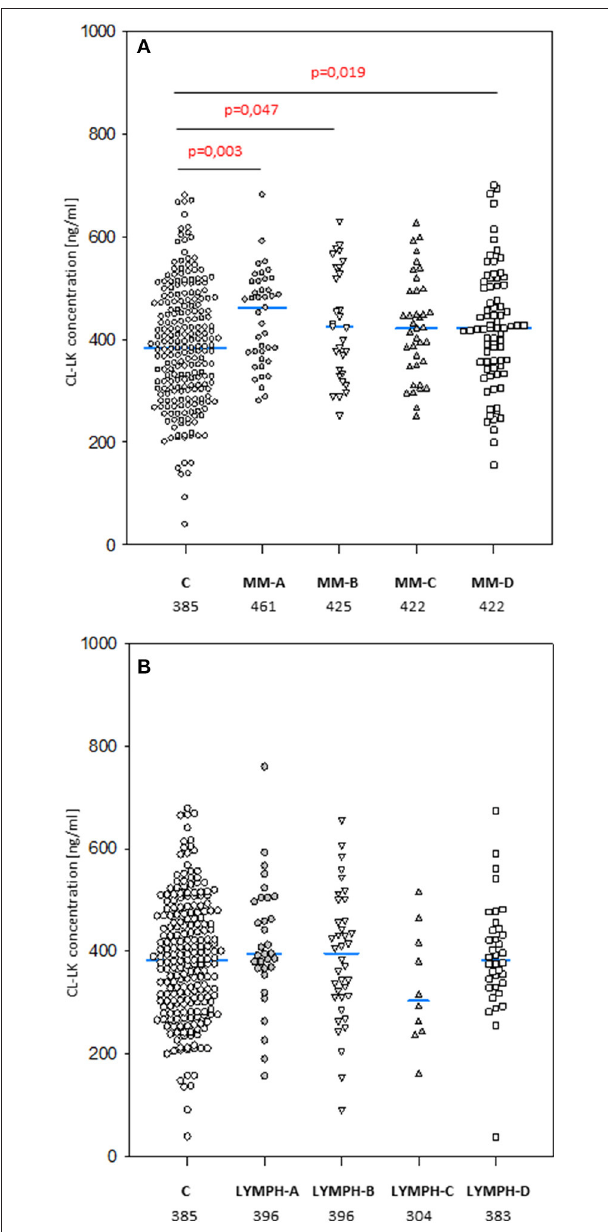
FIGURE 5 | Collectin CL-LK serum concentrations in patients (before conditioning chemotherapy) and controls. Blue bars present median values (given below group descriptions). (A) controls (C) vs. multiple myeloma (MM) patients; (B) controls vs. lymphoma (LYMPH) patients. MM-A, LYMPH-A: patients who experienced infections with proven bacteremia; MM-B, LYMPH-B: patients who experienced infections with no bacteremia; MM-C, LYMPH-C: patients who experienced febrile neutropenia; MM-A, LYMPH-A: patients who experienced none of afore-mentioned complications during hospital stay.